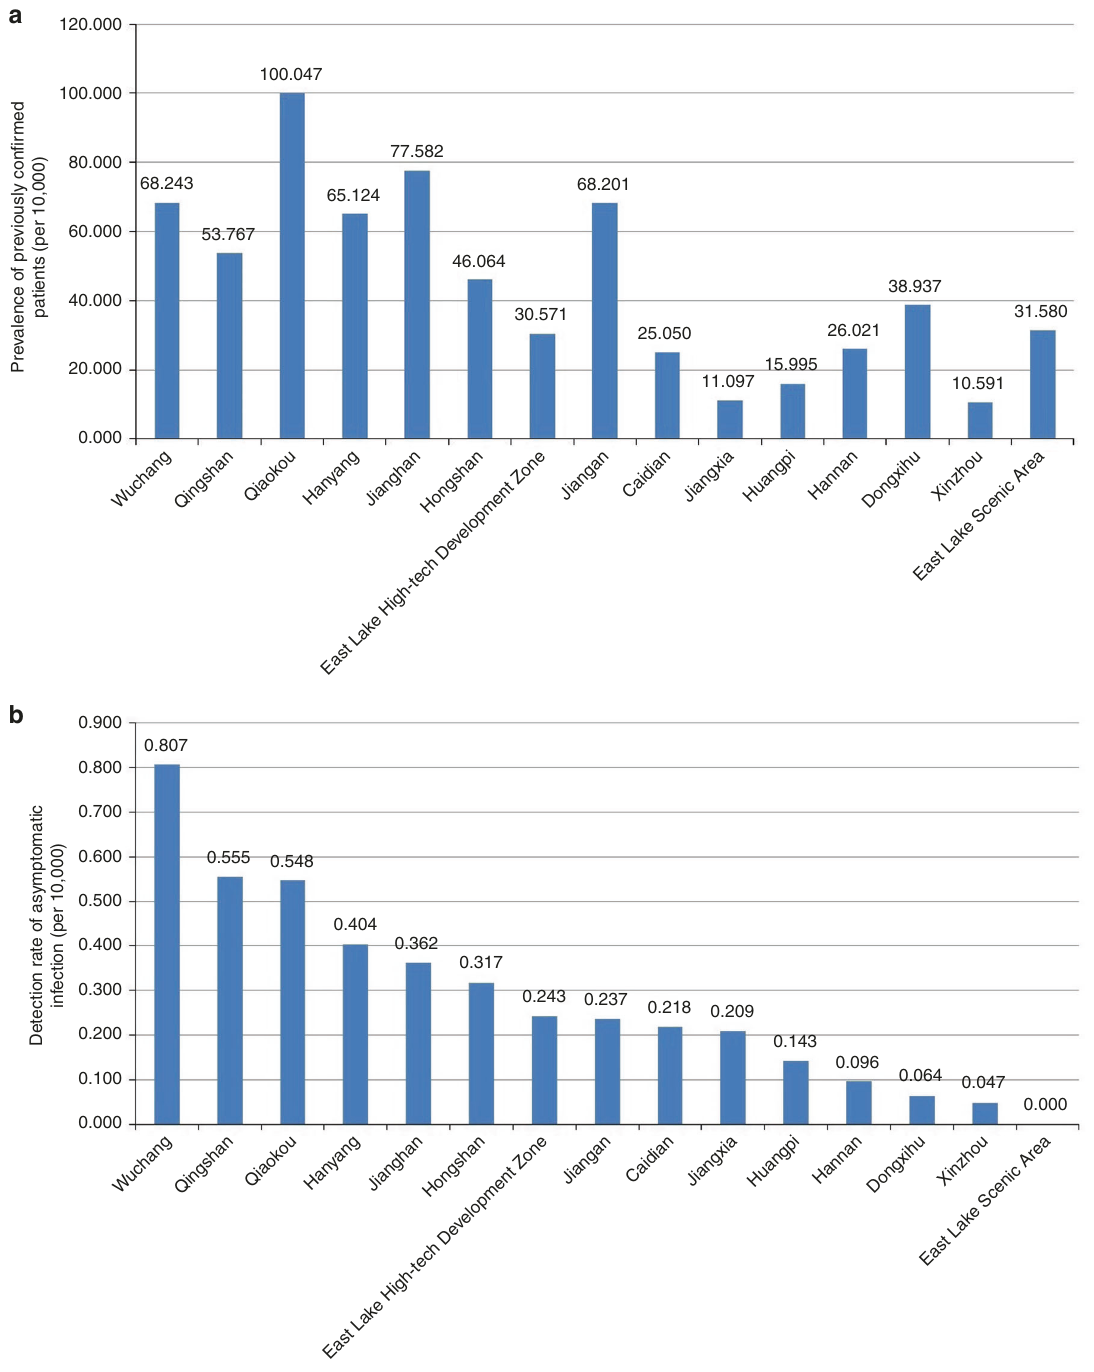
Fig. 3 The prevalence of previously con fi rmed patients and the detection rate of asymptomatic positive cases of COVID-19 in each district in Wuhan. a The prevalence of previously con fi rmed patients of COVID-19 in each district in Wuhan. b The detection rate of asymptomatic positive cases of COVID- 19 in each district in Wuhan. (Source data are provided as s Source Data fi